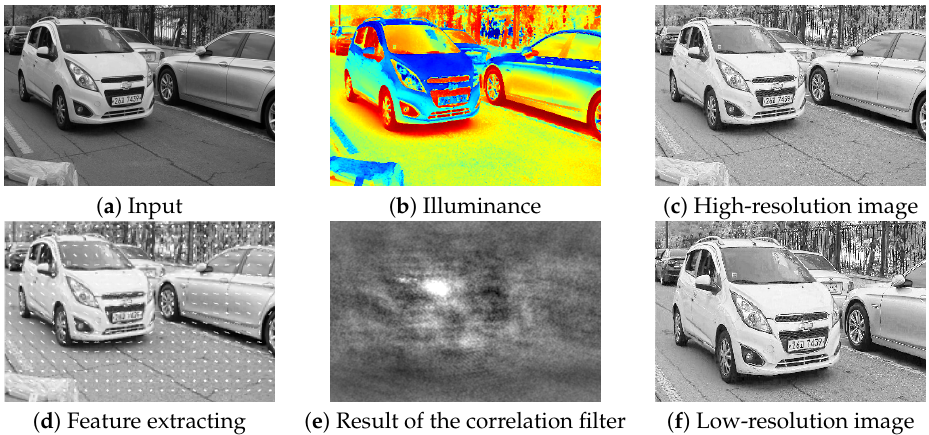
Figure 6. Step-by-step results in the pre-convolution layer ( a – f ).